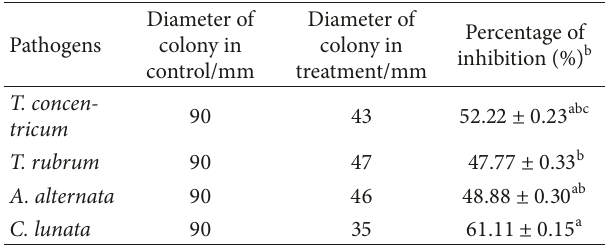
Figure 3: (a) Effect of different pH values on the production and killing activity of killer toxin produced by D. hansenii against pathogenic bacteria and yeasts. (b) Inhibition zone distributed within wells filled with partially purified concentrated killer toxin after 48 h at 37 ∘ C. S. aureus was used as sensitive bacteria. (c) C. albicans was used as sensitive yeast. Values in the same column followed by the same letter are not statistically different by Duncan’s multiple range test at ( 𝑝 < 0.05 ). Table 1: Antifungal activity of D. hansenii against tested fungal pa- thogens measured by the growth inhibition percentage in vitro a